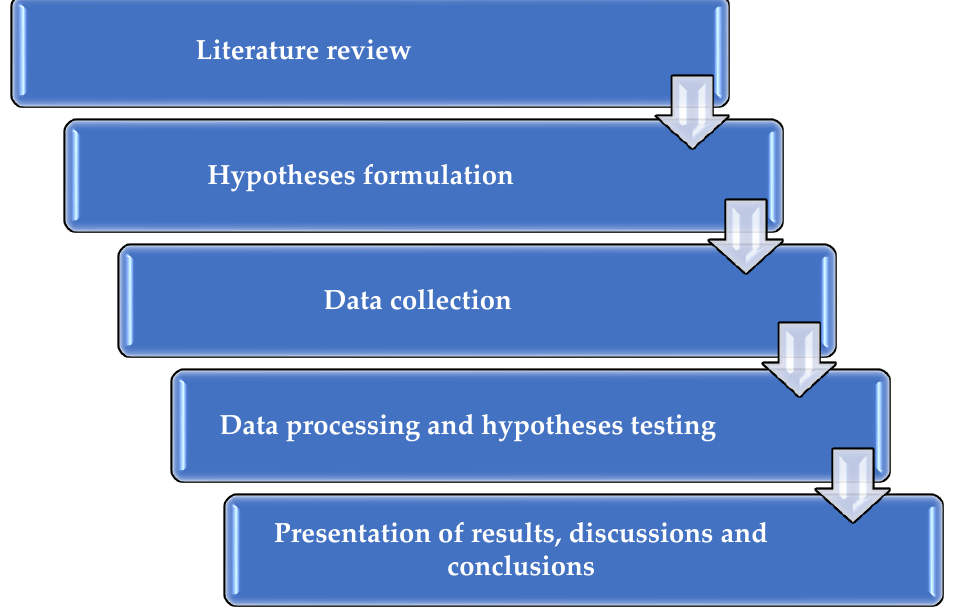
Figure 1. Research process. Source: own construction.